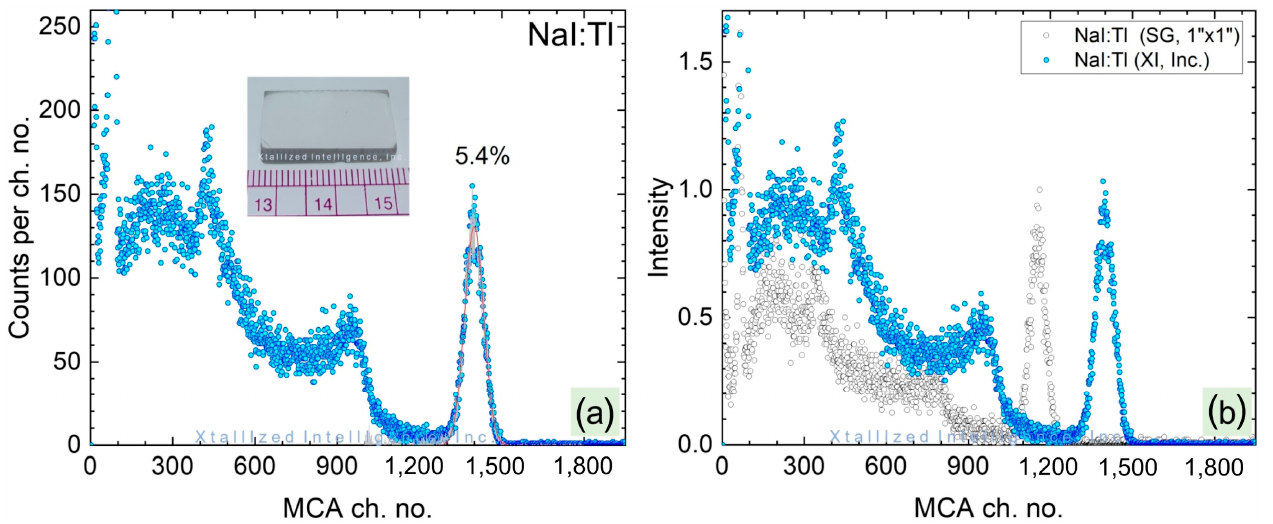
cut and processed from the boule in ( a ).